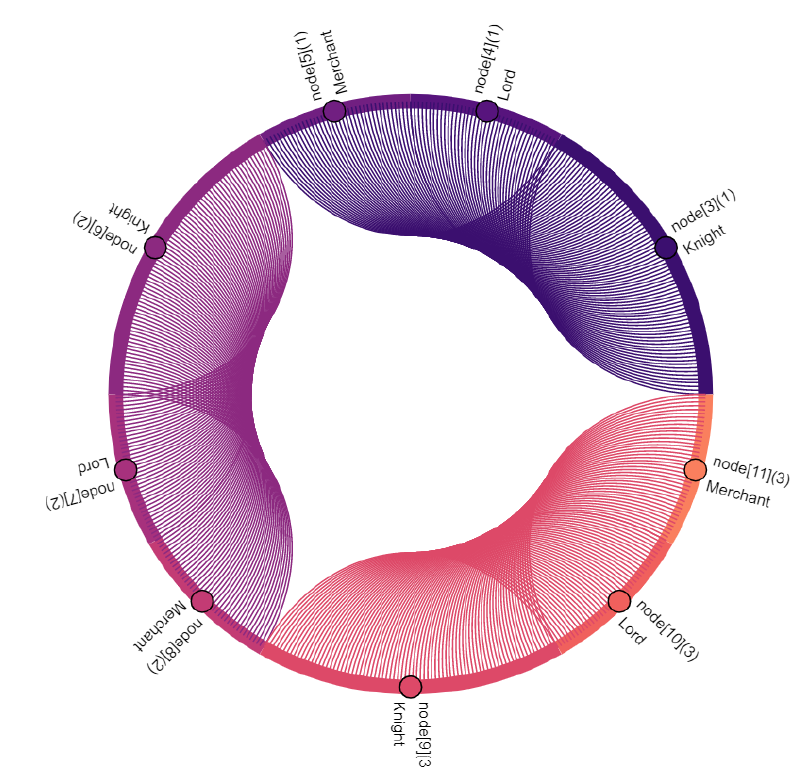
Figure 9. Knights of each vassalage distribute the data from the preceding merchant (see Figure 8) within their own vassalage.